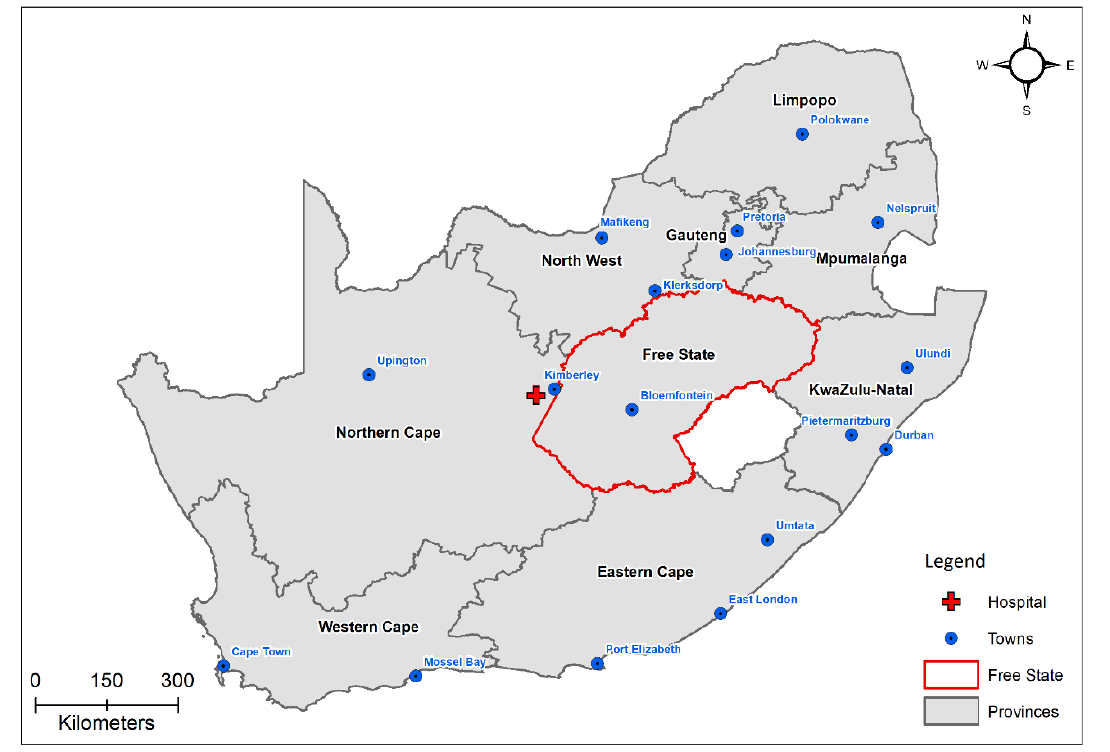
Figure 1. The study area showing Kimberley and the location of the hospital in relation to the Northern Cape and Free States provinces in South Africa.